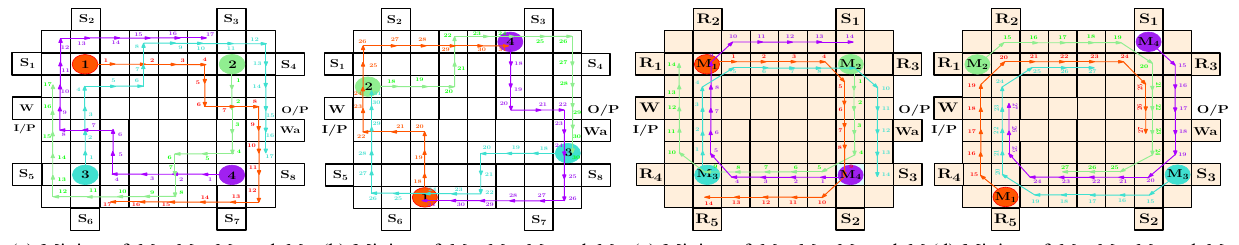
Fig. 13 a and b RBS shift patterns in a 8 × 8 size conventional DMFB chip and c and d for MEDA biochip